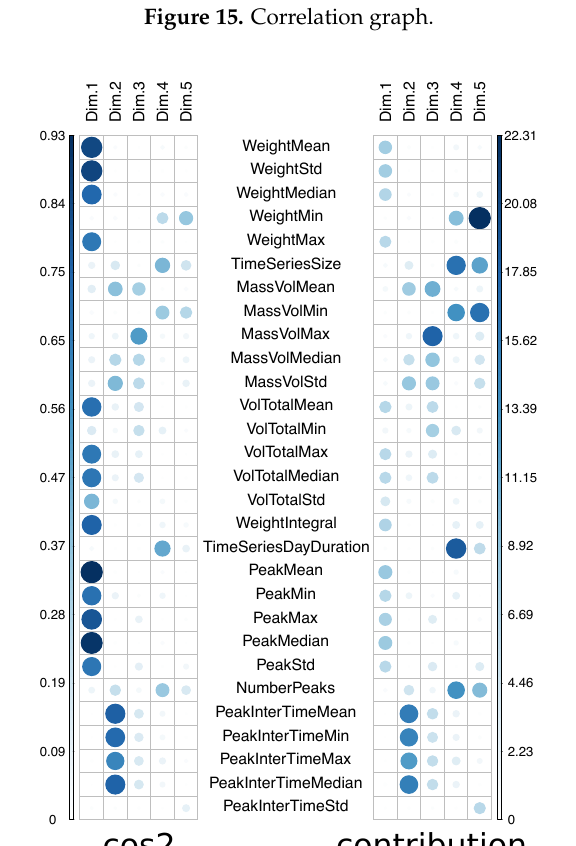
Figure 16. Correlation plot between features and principal components (cos2 and contribution). Figure 17 corresponds to a new visualization of the dispersion plot (see Figure 13) in the coordinate system (Dim. 1, Dim.